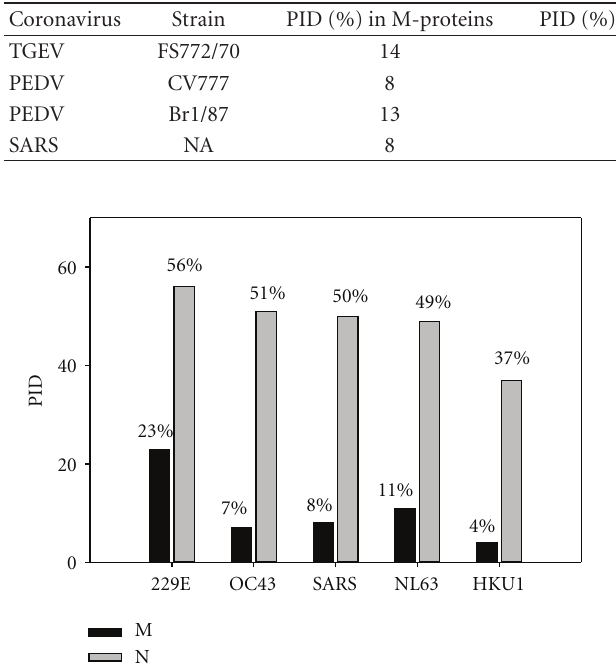
Figure 5: The mean PIDs in di ff erent strains of human coronavirus (HCoV) as compared to the